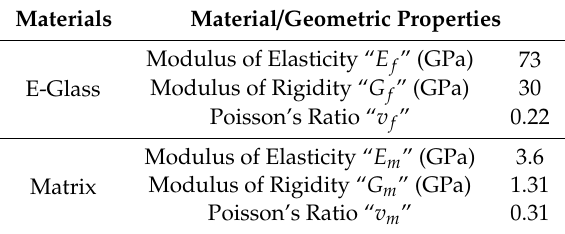
Table 3. Elastic constants of fiber and